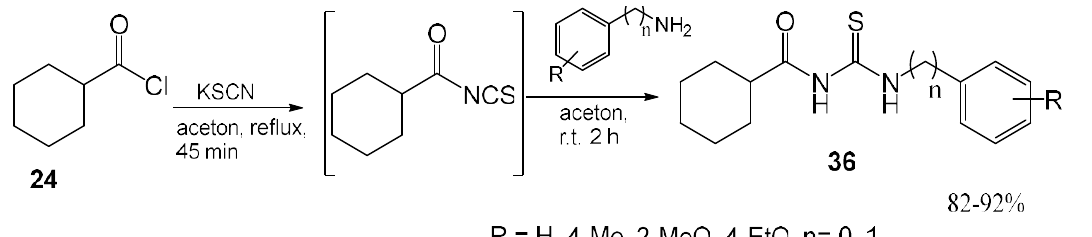
Fig. 11. “One-pot” synthesis of N-